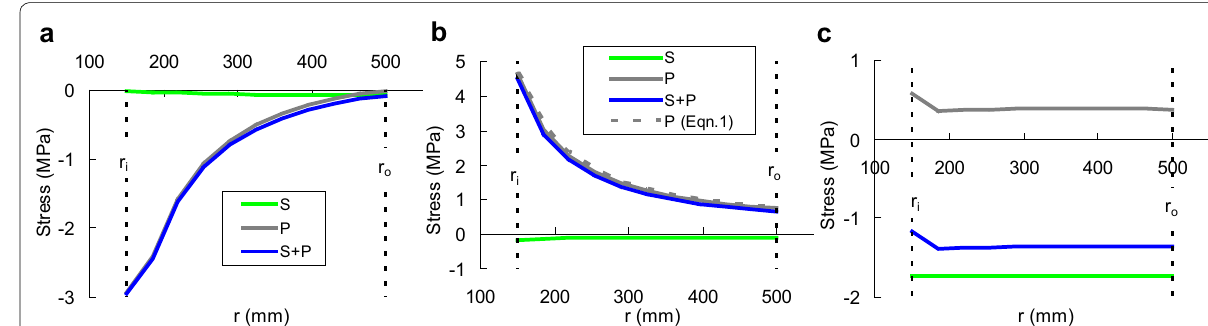
Fig. 8 Stress distributions along the radial direction: a radial stress; b circumferential stress; c vertical stress.